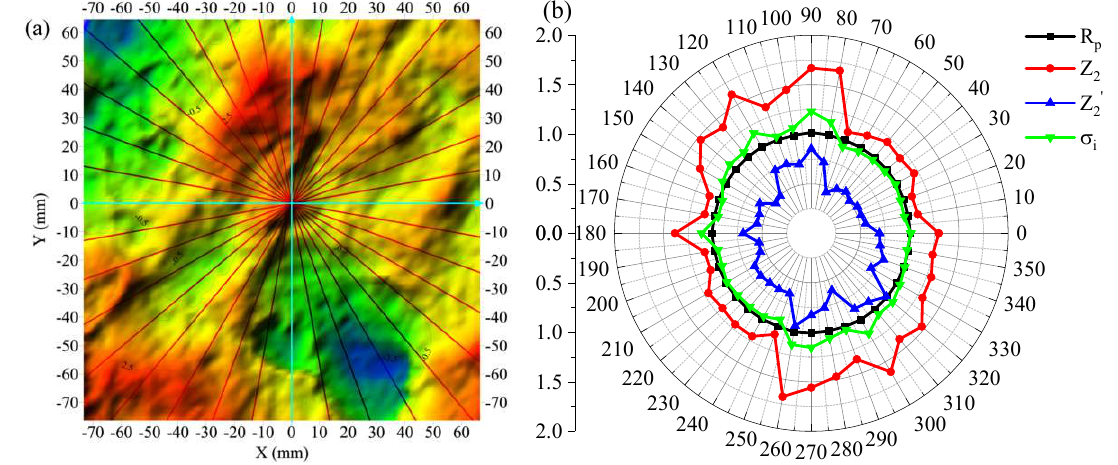
Figure 11. The anisotropy of roughness. ( a ) Profiles along circumferential directions; ( b ) Roughness in radar